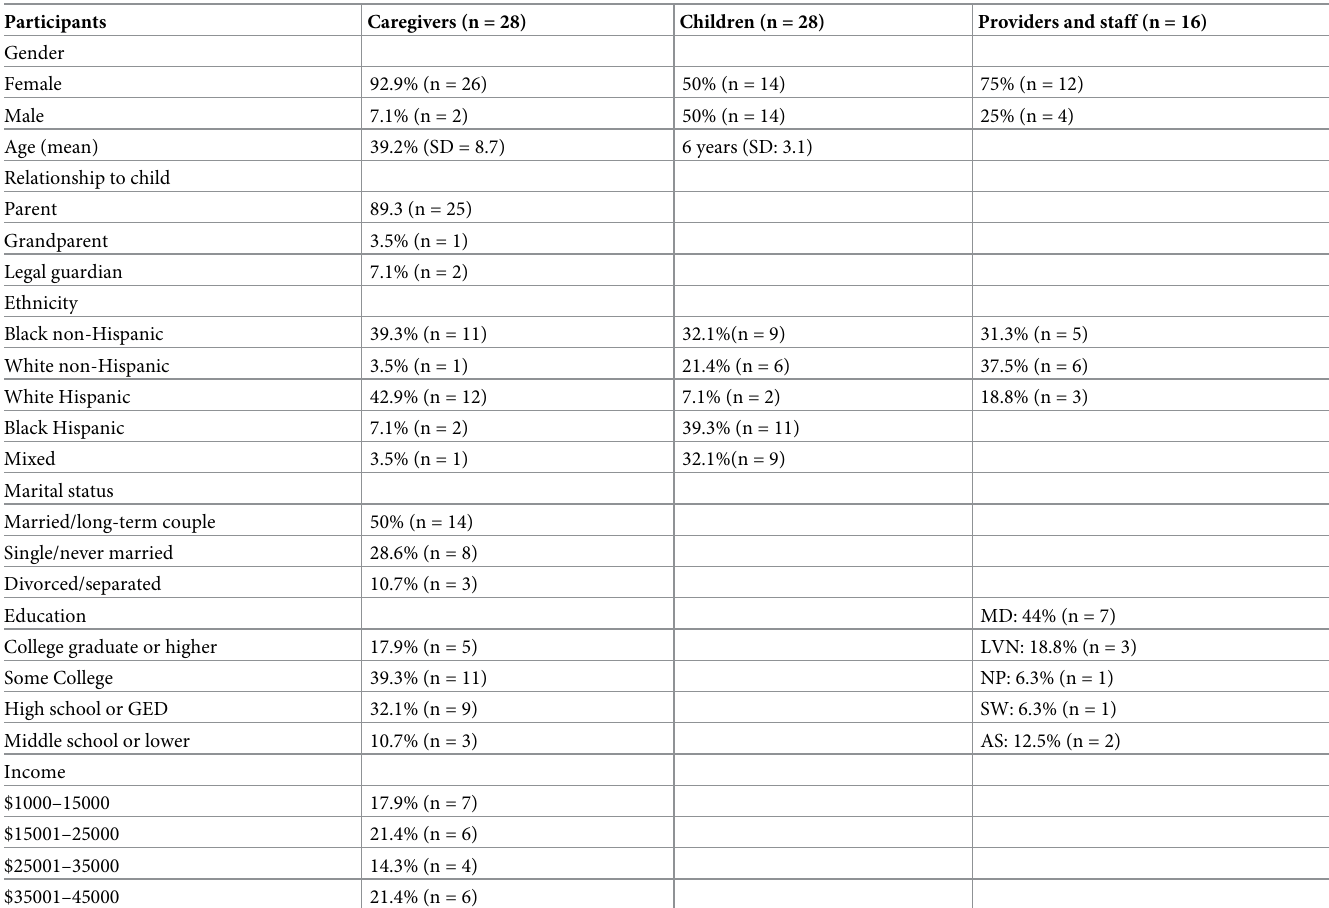
Table 2. Study participants’